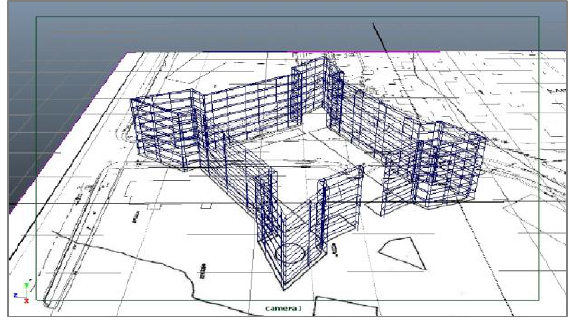
Figure 4: The wireframe model of the 1688